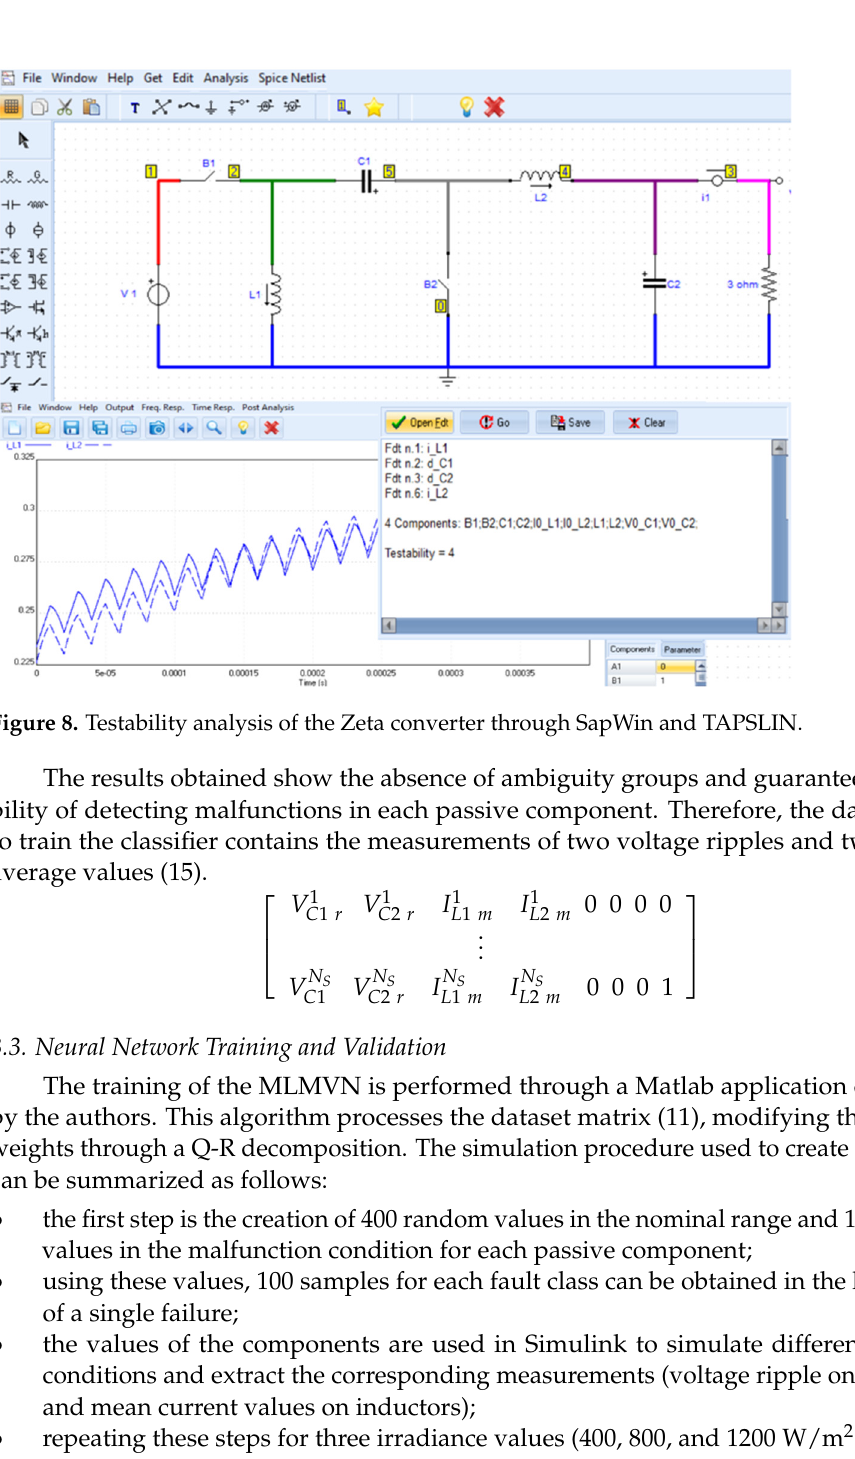
( d ) Figure 7. Sensitivity of the measurements with respect to the variation of environmental conditions; ( a ) ripple of the voltage on the first capacitor V C1ripple ; ( b ) ripple of the voltage on the second capacitor V C2ripple ; ( c ) mean value of the current through the first inductor I L1mean ; ( d ) mean value of the current through the second inductor I L2mean . 3.2. Testability Assessment of the Zeta Converter